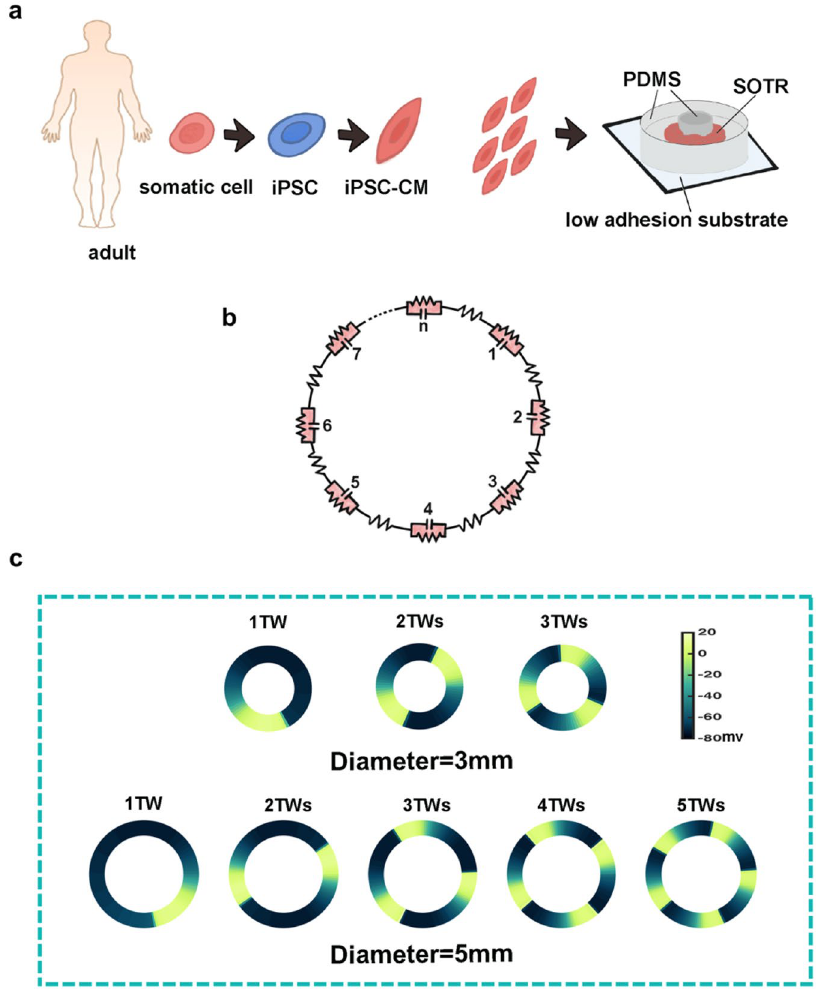
Figure 1. Generation of experimental cardiomyocytes rings derived from human induced pluripotent stem cells and the ring-shaped cable model in the simulation. ( a ) Schematic of hiPSC-CMs and self-organized tissue rings (SOTR) in the experiment (PDMS, polydimethylsiloxane). ( b ) Schematic of the ring-shaped cable model in the simulation. ( c ) Examples of different numbers of waves traveling around the 3- and 5-mm rings in simulations (TW, traveling